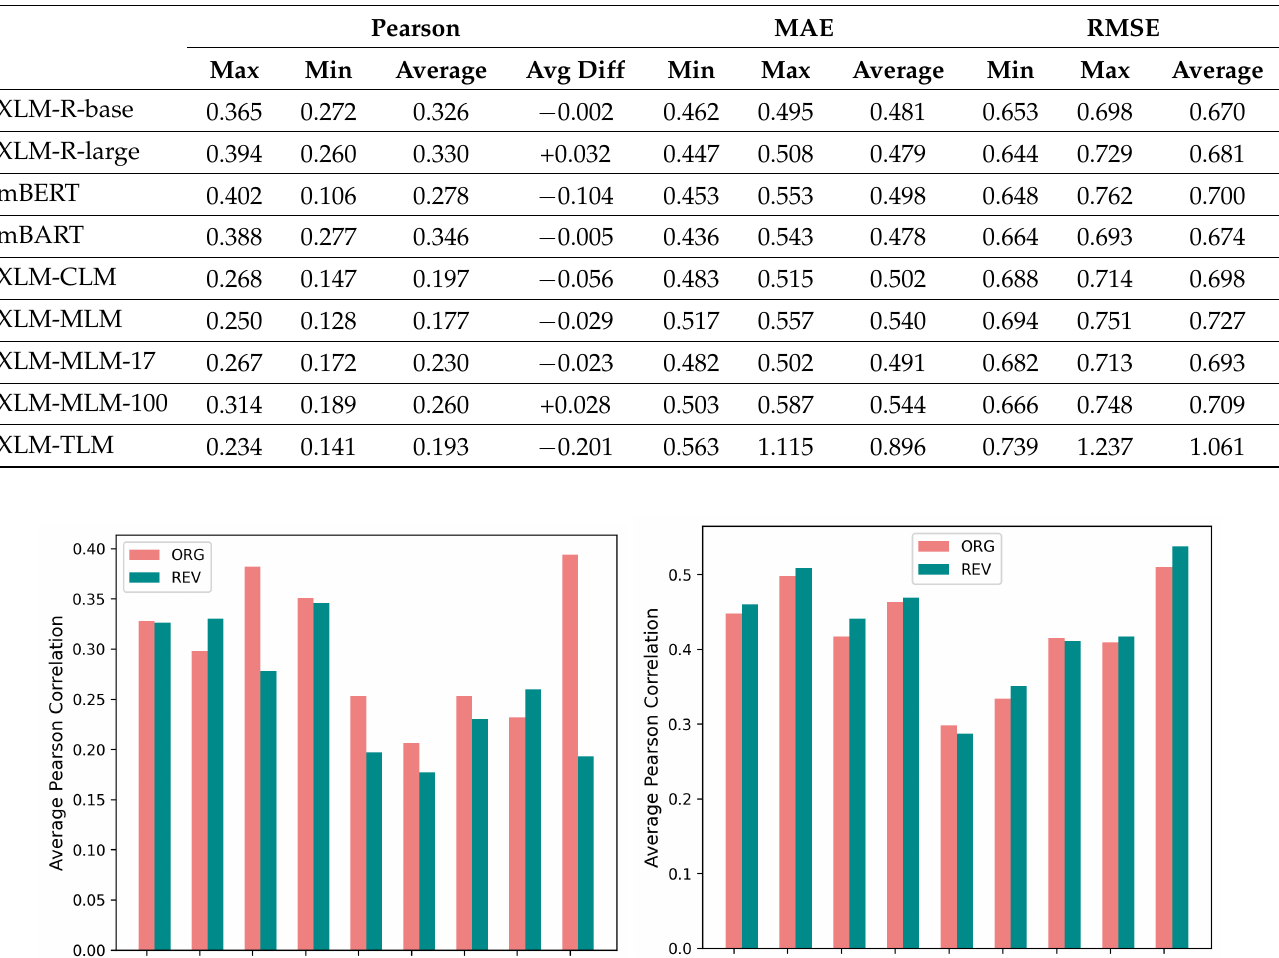
Table 4. Results of mPLM finetuning with inverted inputs for the test set of WMT20 sub-task 1.